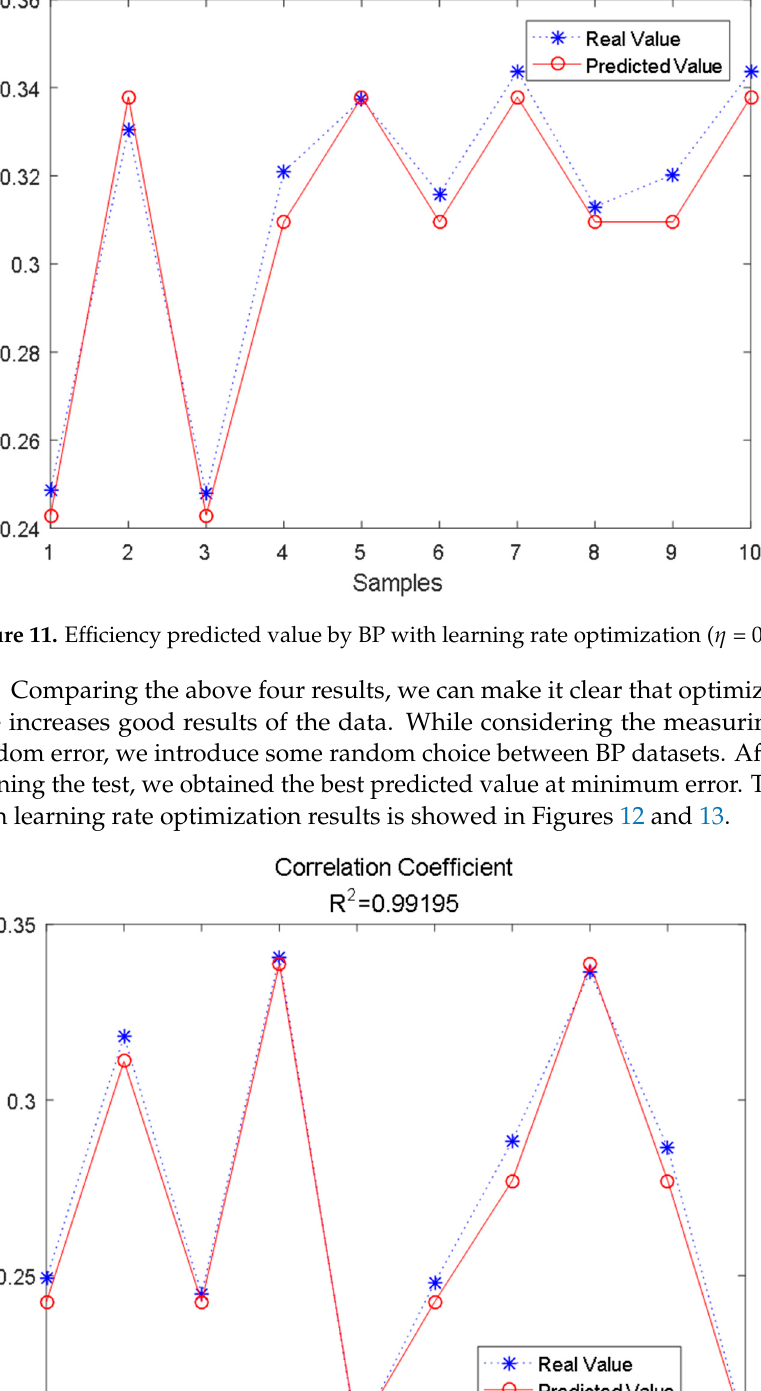
Figure 10. Efficiency predicted value by BP with learning rate optimization ( η = 0.3924).